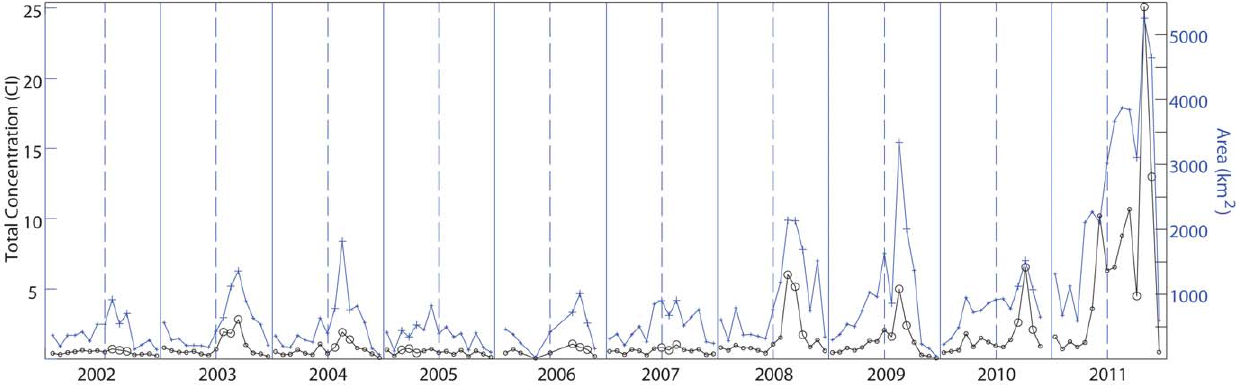
Figure 2. Time series of bloom intensity (black) and area . 0.001 CI (blue) from the cumulative CI for each 10-day composites. The intensity is the sum of CI-values at all pixels within the image. The area is determined from the total number of pixels with CI . 0.001. Circles mark the three composites used to determine the annual severity. Each year has 15 composites, from June 1–10 to October 19–28. The dashed grid line marks the August 10–19 period.